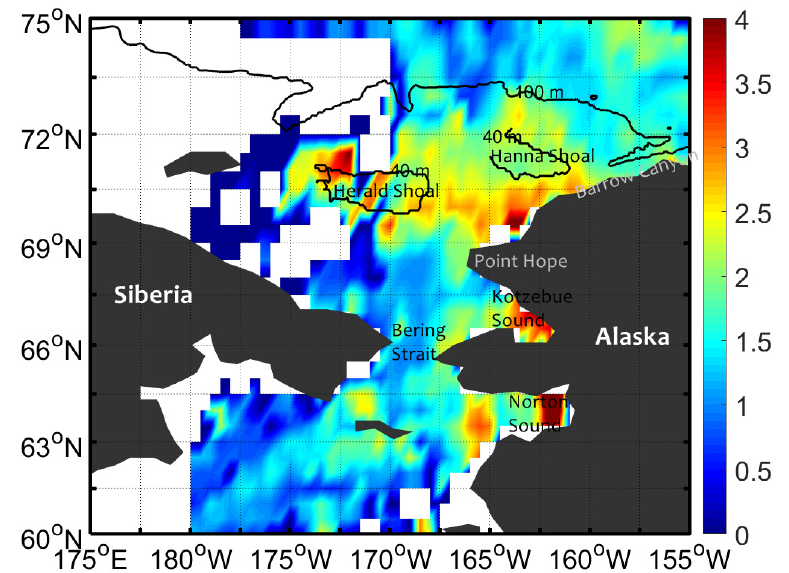
Figure 4. Standard deviation (shaded) of summer mean surface temperature from 1974 to 2017. The solid black contours represent 100 m and 40 m isobaths.